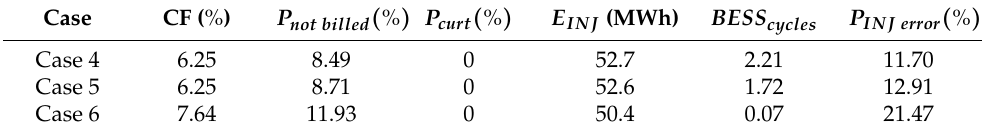
Table 5. KPIs evaluation for Strategy